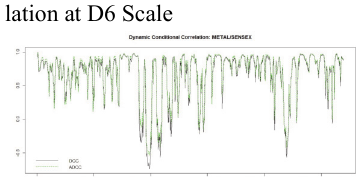
Fig. 12. Dynamic Conditional Correla- tion at D1 Scale